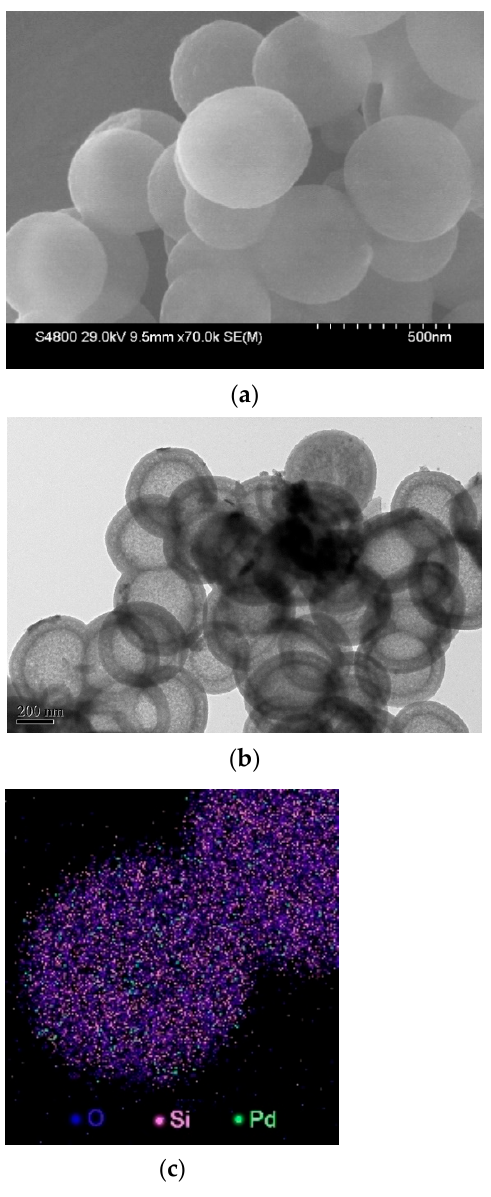
Figure 5. ( a ) The scanning electron microscopy (SEM) images of catalyst 3 , ( b ) the transmission electron microscopy (TEM) images of catalyst 3 , ( c ) a TEM image with the chemical mapping of 3 showing the distribution of Si (pink), O (blue), and Pd (green).